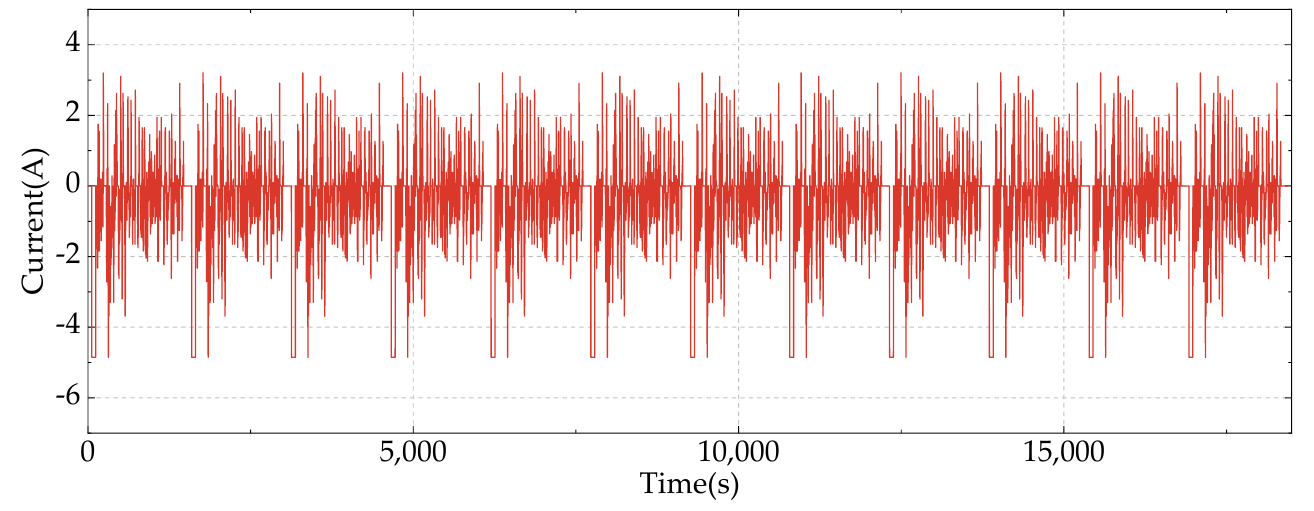
Figure 7. Excitation current under UDDS condition.